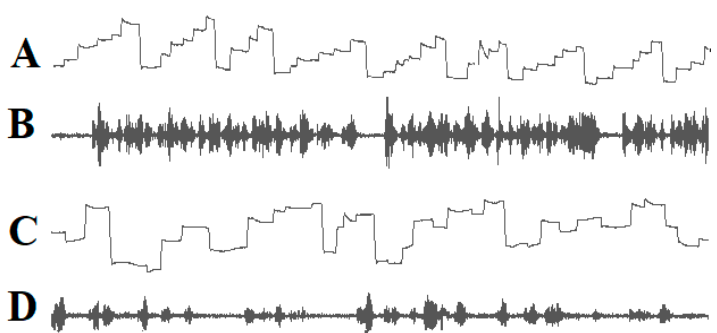
Figure 1. Eye movements ( A ) and speech spectrogram ( B ) of a good reader. Ascending lines: eye movements to the right; descending lines: eye movements to the left. The reader exerts a sequence of staircase-like eye movements in the reading direction. The speech spectrogram shows fluent reading without interruptions. Irregular eye movements ( C ) and the speech spectrogram ( D ) of a dyslexic child. The child exerts many eye movements opposite to the reading direction. The speech spectrogram demonstrates that the child reads haltingly with many pauses.